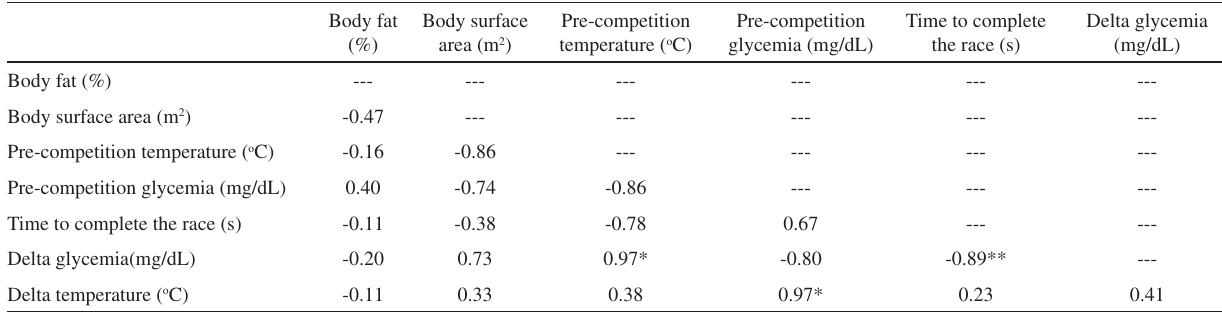
Table 3 - Bivariate linear correlation between anthropometric and performance data among women